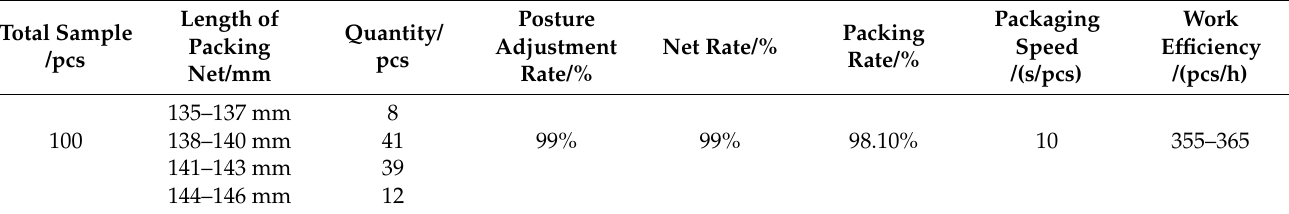
Figure 24. Working screen of the nesting device.